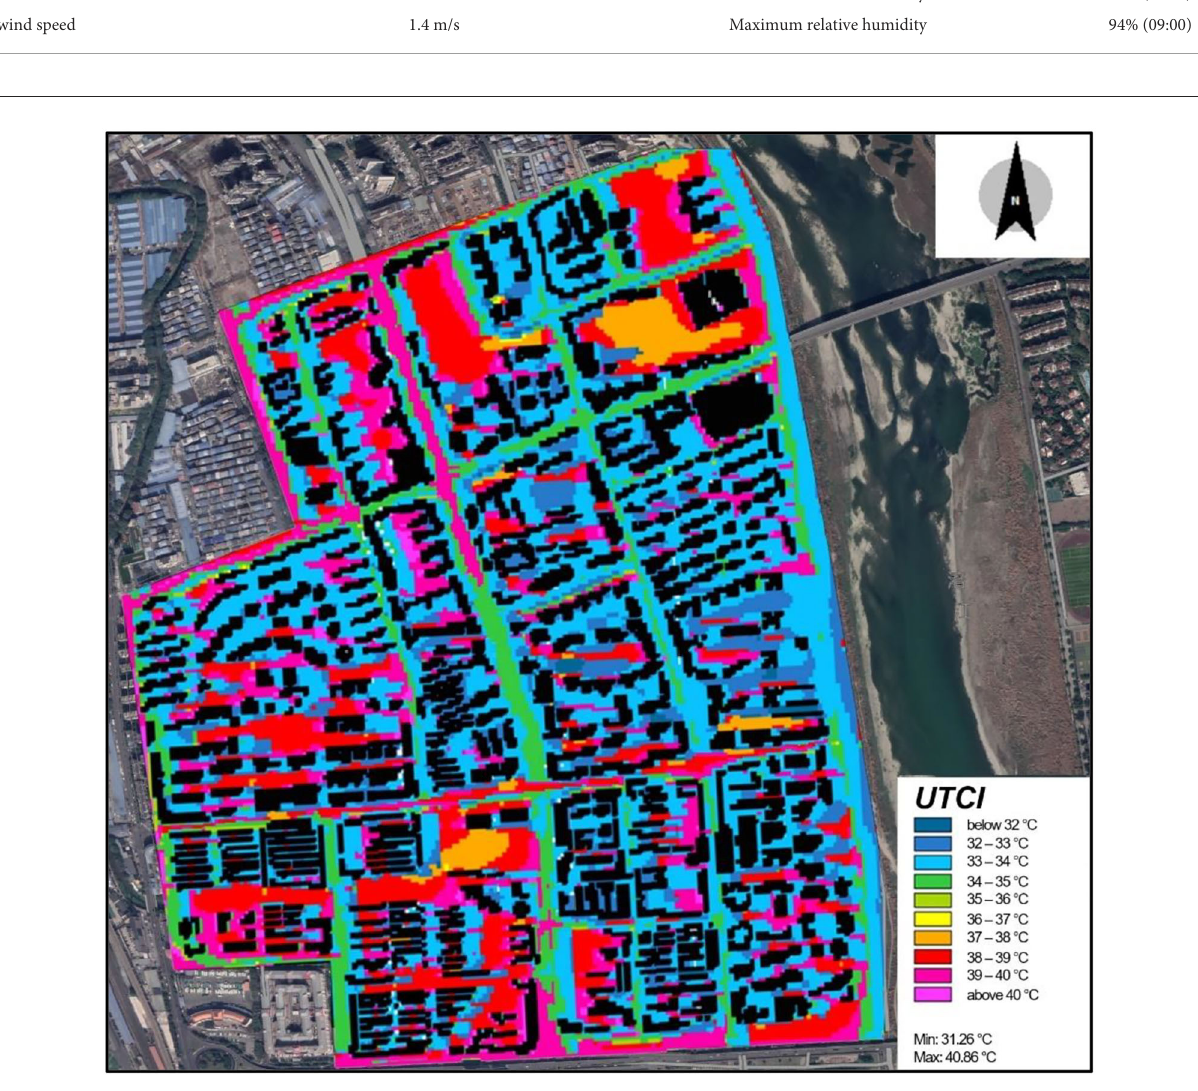
FIGURE7 Distribution of simulated UTCI of the study